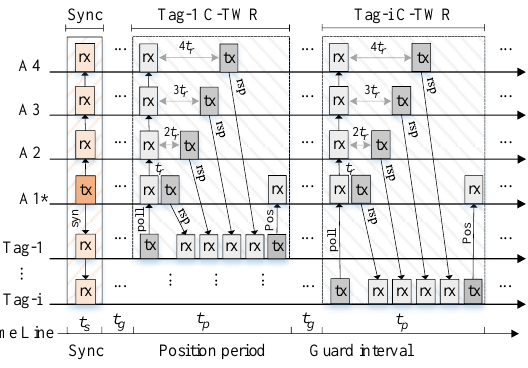
Figure 1. The schematic diagram of the positioning